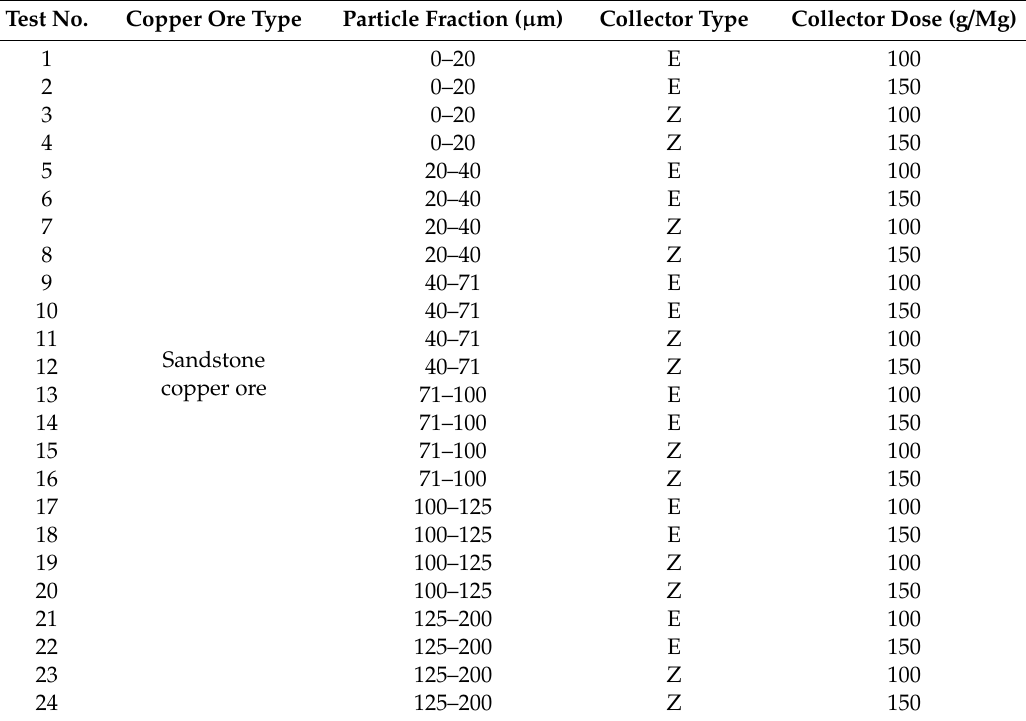
Table 3. The variability range of parameters of the flotation test planned and carried out according to the experimental plan (E—aqueous solution of ethyl sodium xanthate; Z—aqueous solution of isobutyl sodium xanthate)—Denver machine, sandstone copper ore.